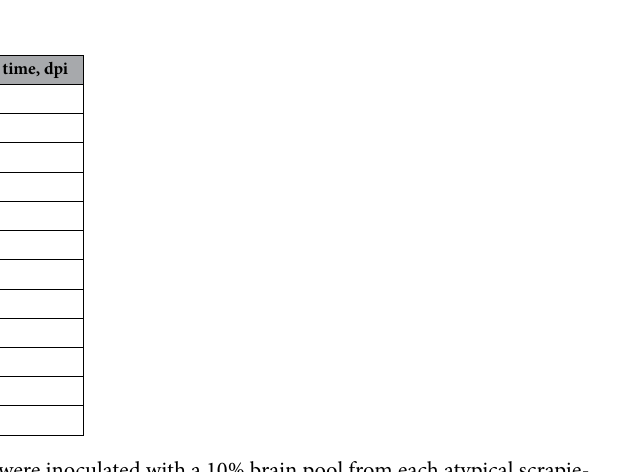
Table 3. Bioassay in tgPo mice. a Mice were inoculated with a 10% brain pool from each atypical scrapie- challenged